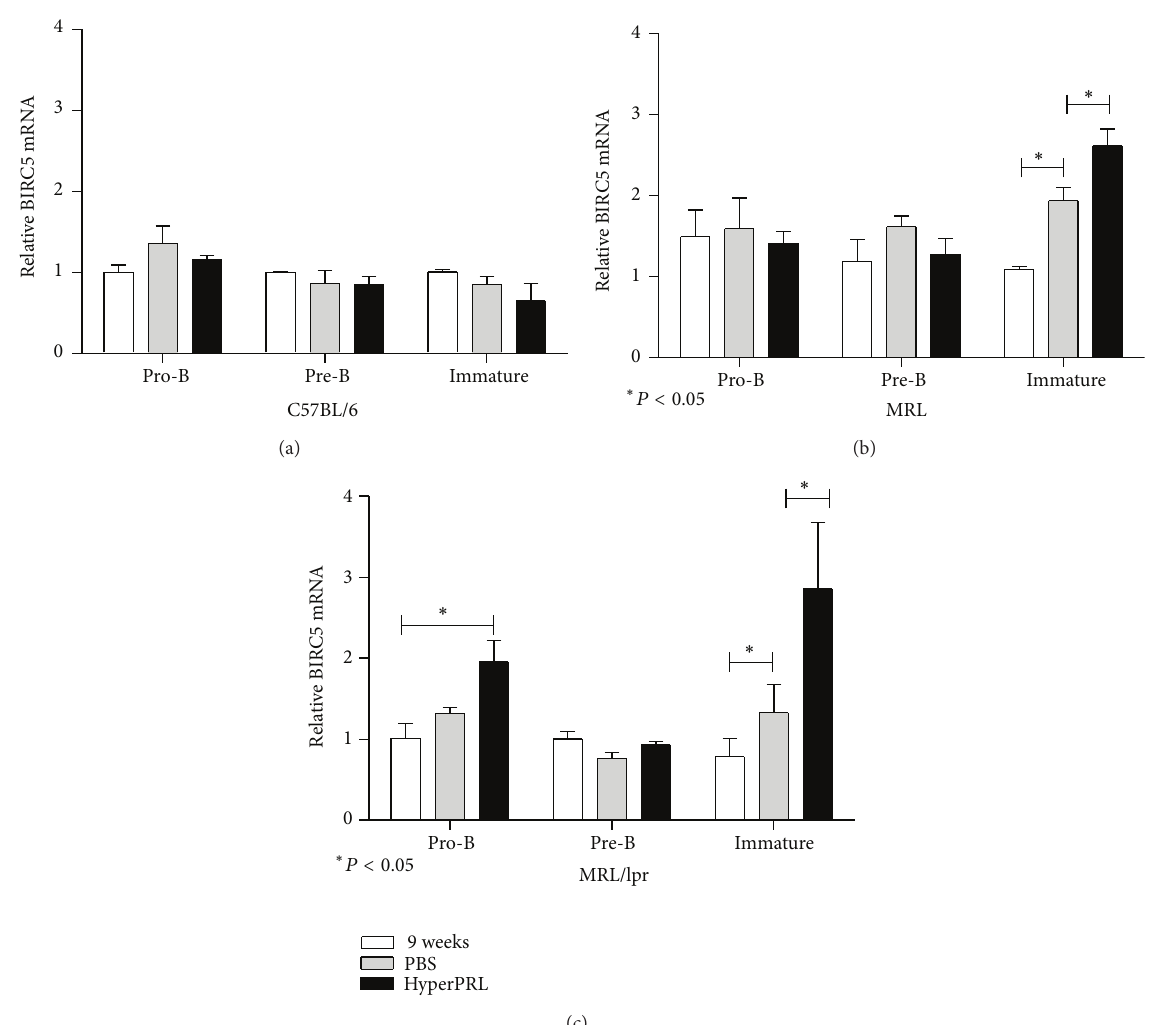
Figure 5: Increase in BIRC5 expression in immature cells. Nine-week-old mice were treated with metoclopramide (200 𝜇 g/100 𝜇 L) to induce hyperprolactinaemia (HyperPRL) or PBS (100 𝜇 L) for 6 weeks. At the end of the treatment, pro-B, pre-B and immature B cells were purified using flow cytometry in three independent experiments using three mice per experiment. Using RT-PCR, the BIRC5 mRNA expression was determined. (a) C57BL/6 mice; (b) MRL mice; (c) MRL/lpr mice. The asterisks denote statistical significance between populations with the 𝑃 value